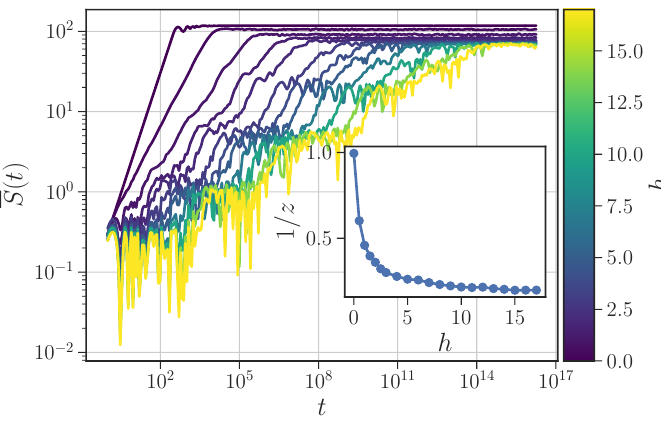
Figure 11: Free fermions entanglement as a function of time for various potential strengths, starting from random high energy initial product states on the chain of L = 610 sites. Inset: exponent of the power-law fit S ( t ) ∝ t 1 / z .